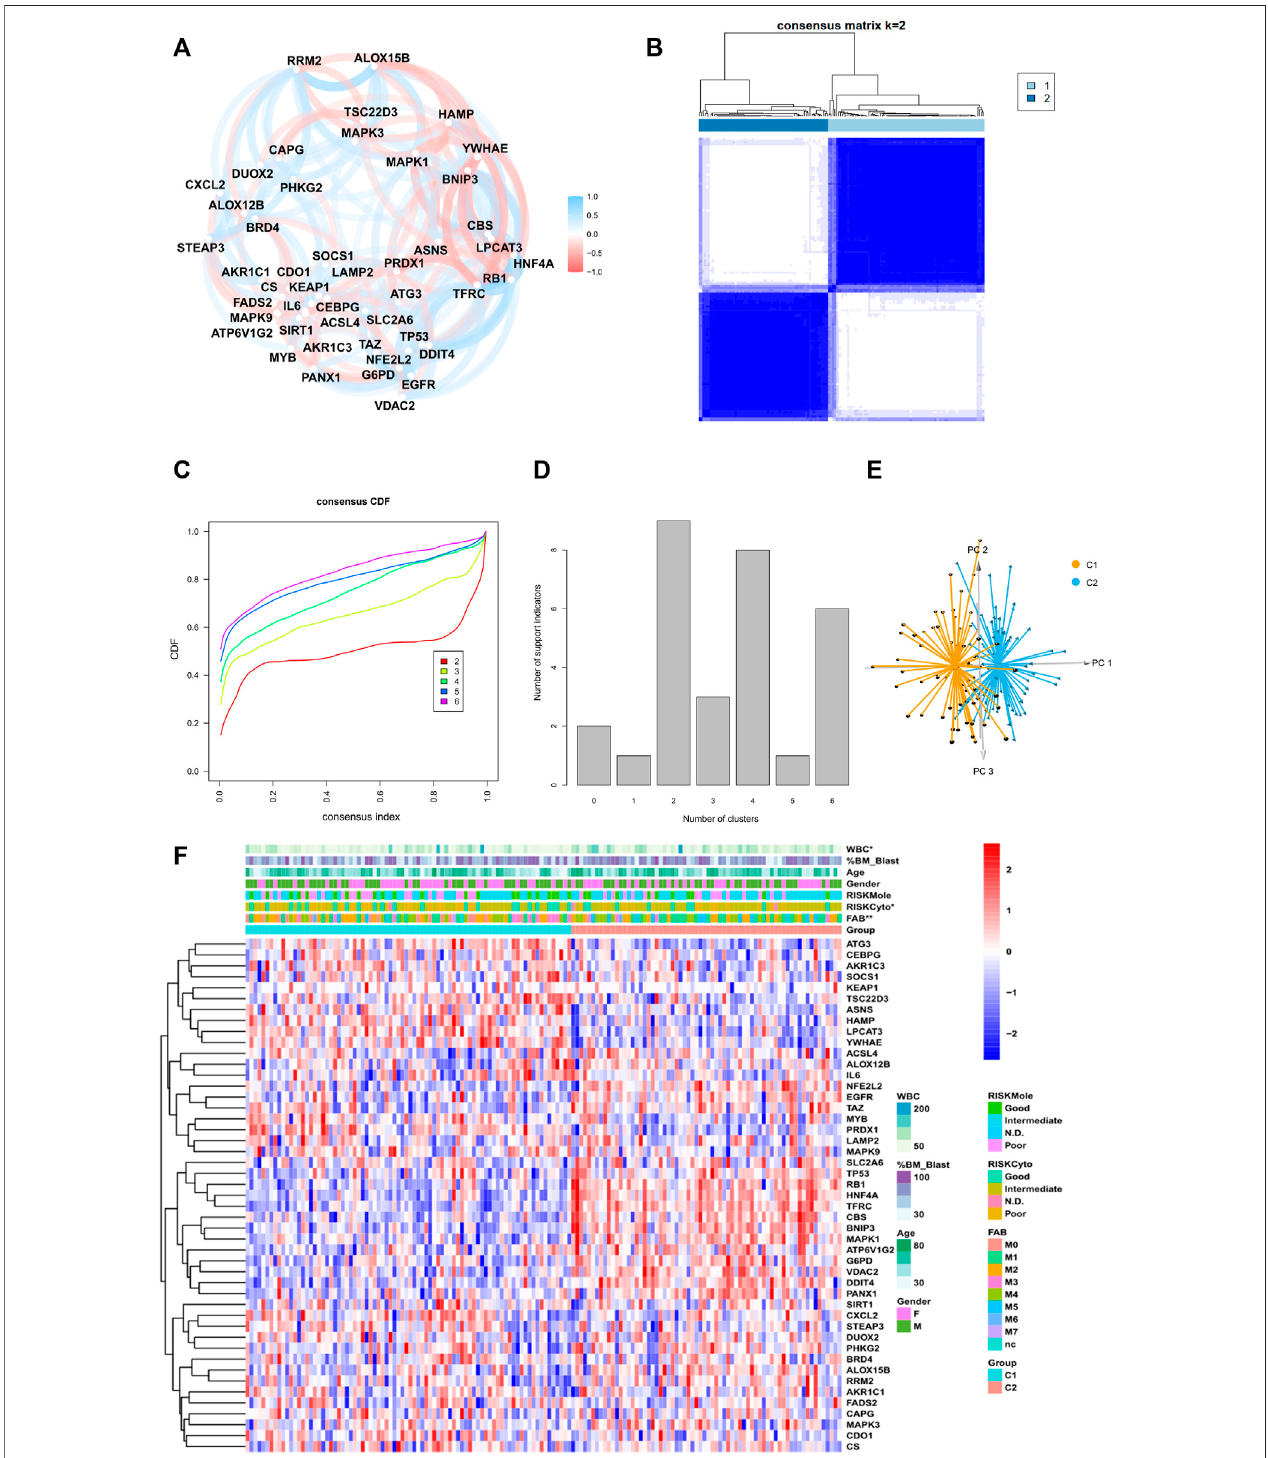
FIGURE 2 | Identi fi cation of two subtypes in the TCGA cohort. (A) Correlation plot of 47 genes, (B) consensus matrix of two subtypes, (C) CDF curve, and (D) indicationbarplotofk-valueusedforconsensusclustering. (E) PCAplotoftwosubtypes. (F) Heatmapof47-geneexpressionwithclinicalinformationintheTCGAcohort. (Categorical variables, Chi-square tests; continuous variable, Wilcoxon tests * p < 0.05; ** p < 0.01; *** p < 0.001).